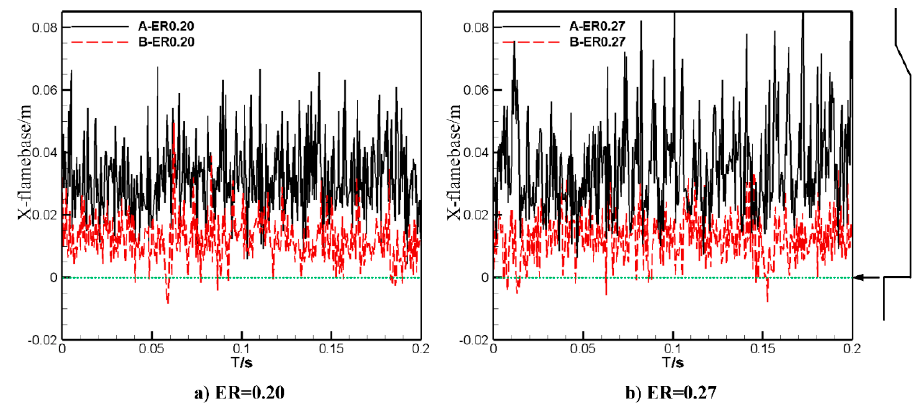
Figure 8. Flamebase oscillations in the cases of injection schemes ( a ) and ( b ) at ER0.20 and 0.27 (the position of the cavity leading edge is the coordinate origin of the flamebase oscillation).